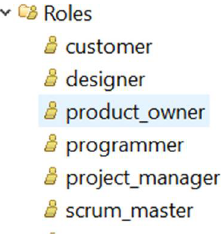
Figure 7. Defined roles in the modeling.